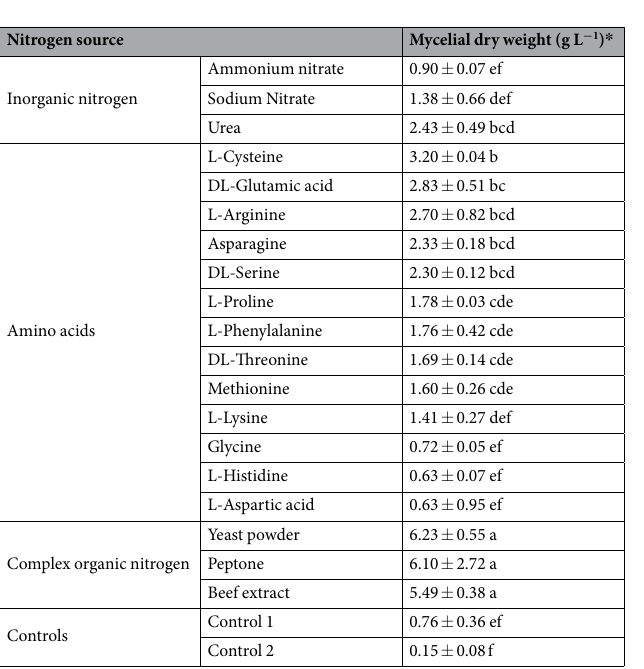
Table 7. Effect of nitrogen source on the mycelial growth of Isaria farinosa . * Mean ± SE. Values followed by the same letters within a column do not differ significantly (ANOVA, P =